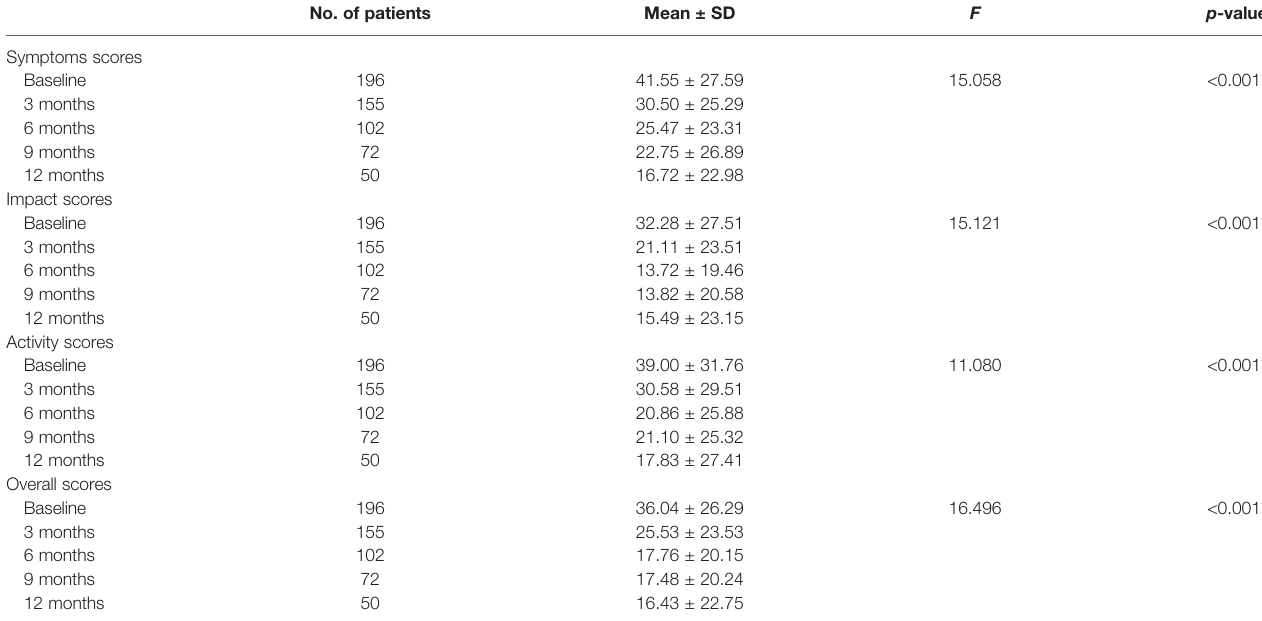
TABLE 5 | Mean scores of participants answering the SGRQ.